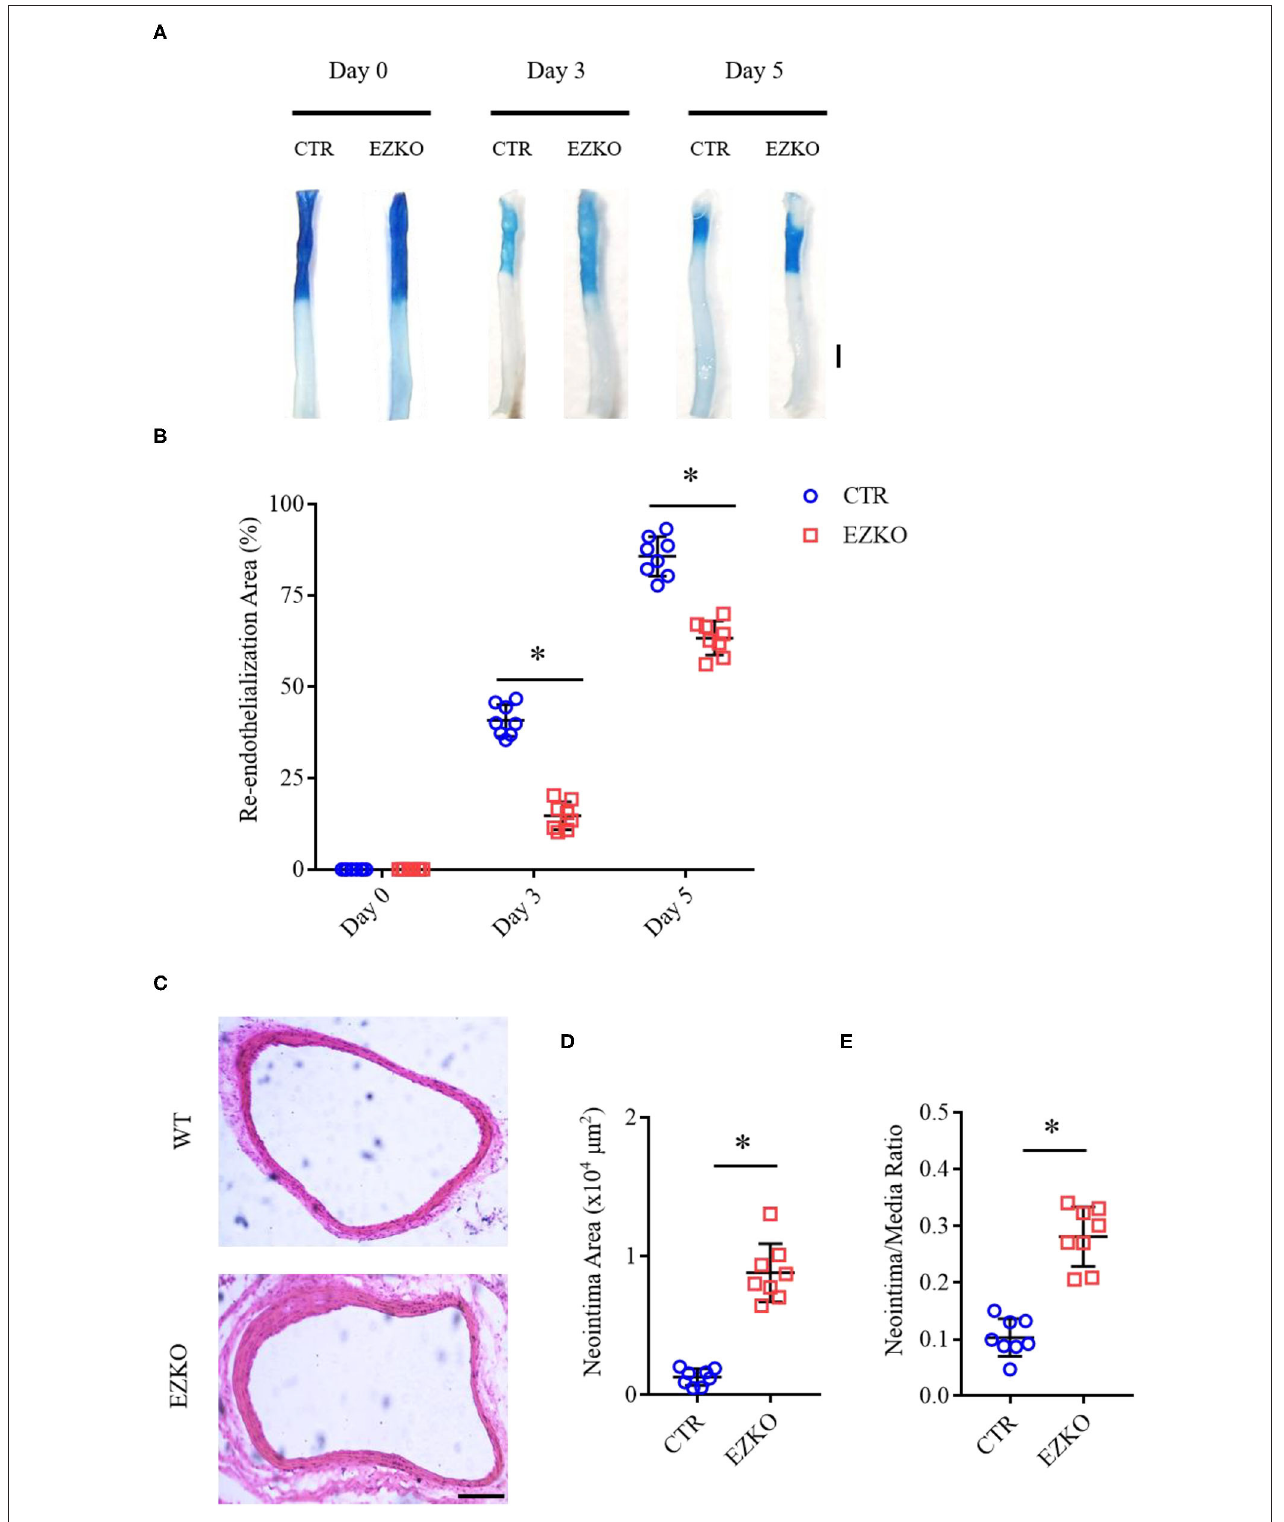
FIGURE 4 | Zyxin deletion in ECs impairs the re-endothelialization and promotes neointima formation in wire-injured mouse carotid arteries. (A) Representative image of re-endothelialization assessed by Evans blue staining showing endothelial denudation of carotid arteries 0, 3, and 5 days after injury (scale bar, 1mm). (B) Quantification of the re-endothelialization area after injury. (C) Neointima formation was determined using cross-sections of carotid arteries by HE staining 28 days after injury (scale bar, 100 µ m). (D) Quantification of neointima formation area. (E) Quantification of neointima/media ratio. Mean ± SD, n = 8, * P < 0.05. Test of normality: P > 0.05, test of homogeneity: P > 0.05. CTR, control; EZKO, endothelium-specific zyxin knockout.